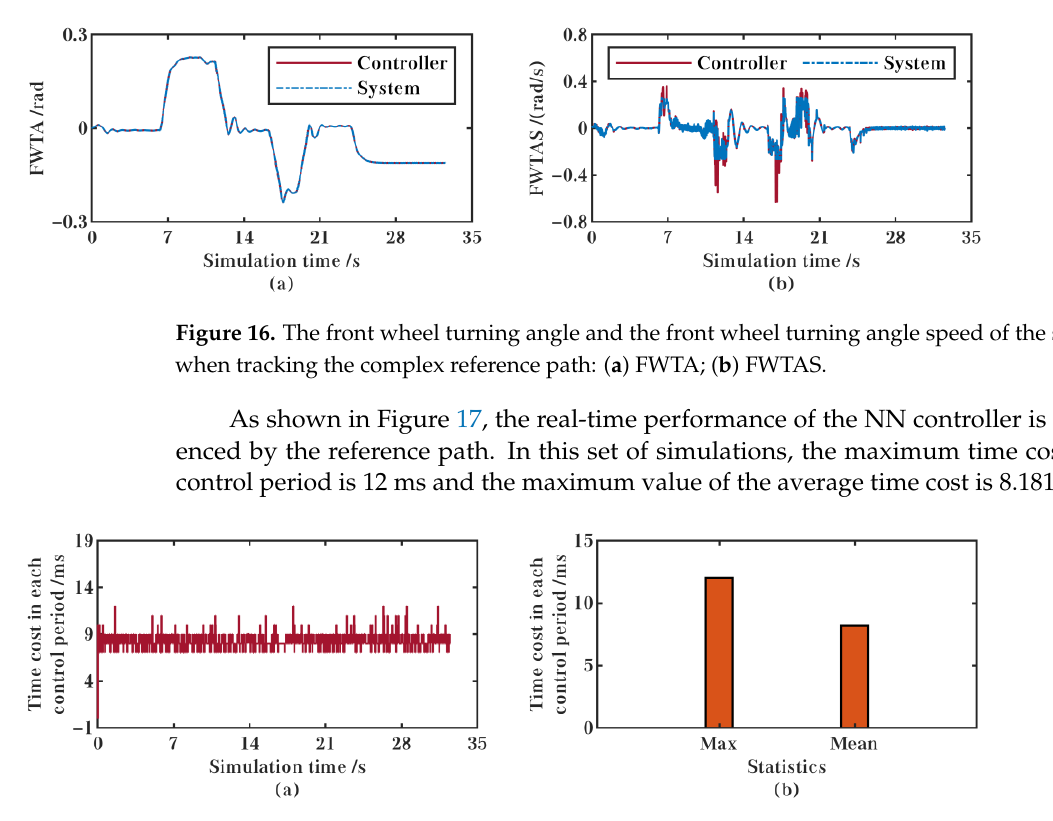
Figure 17. The real-time performance of the simulation when tracking the complex reference path: ( a ) the time-series diagram; ( b ) the statistical diagram.